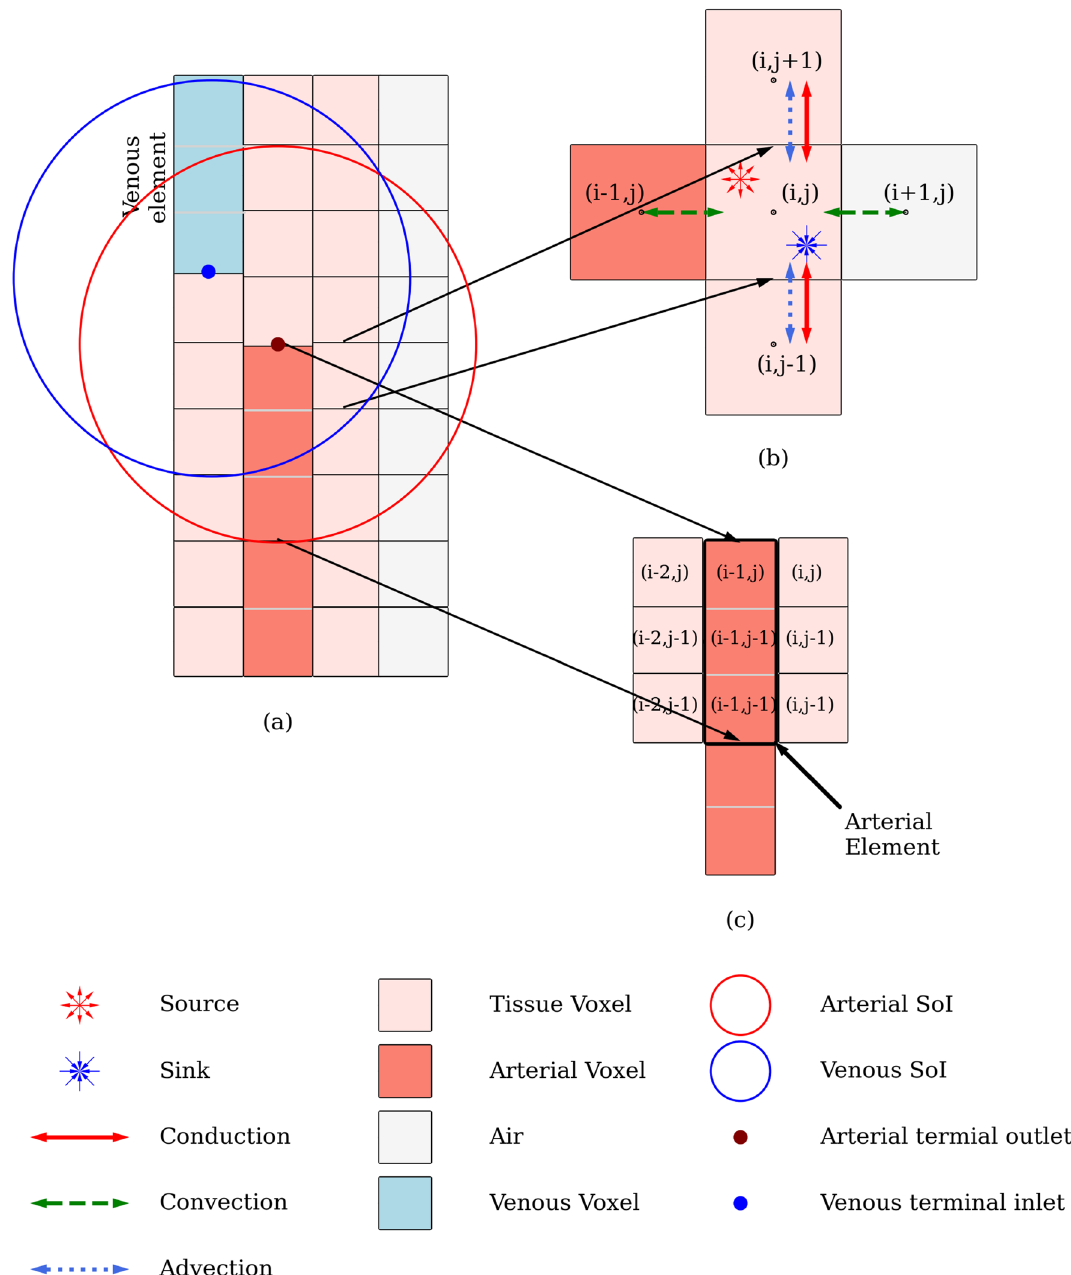
Figure 2. An illustrative description of the Heat transfer model. ( a ) A small voxel domain representing artery, vein, and tissue, with SoI for an artery and vein. ( b ) Zoomed in voxel (i, j) with its neighbor. The convective heat exchange between (i − 1, j) and (i, j) is calculated using Eq. (15c) and between (i + 1, j) and (i, j) using Eq. (15b). Conduction between voxels (i, j + 1) and (i, j − 1) with (i, j) is calculated using Eq. (15a). The advection between tissue voxels and advection due to the source term are modeled using the second term and third term on RHS of Eq. (15), respectively. ( c ) Multiscale mesh example for heat transfer between a blood vessel and tissue. The arterial element represented using a thick border consists of multiple Arterial